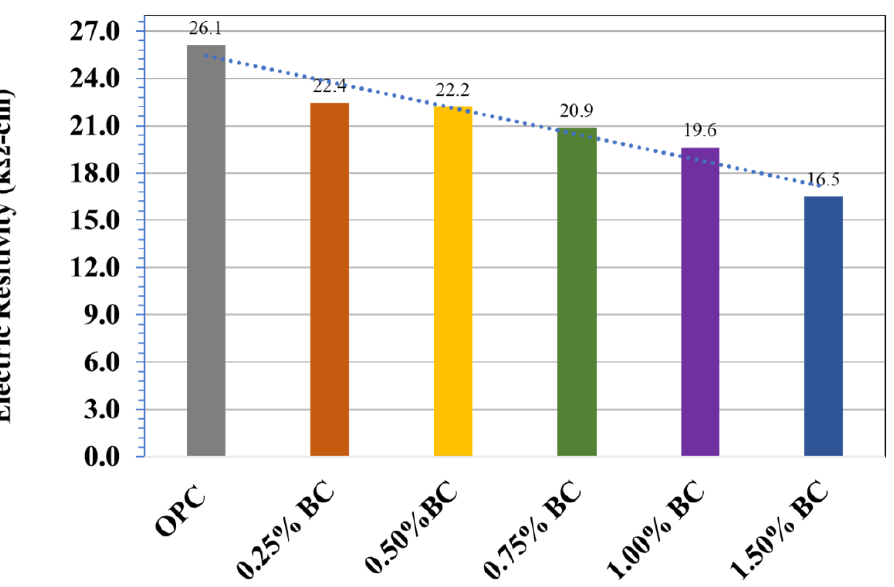
Figure 9. Electric resistivity of different concrete samples.